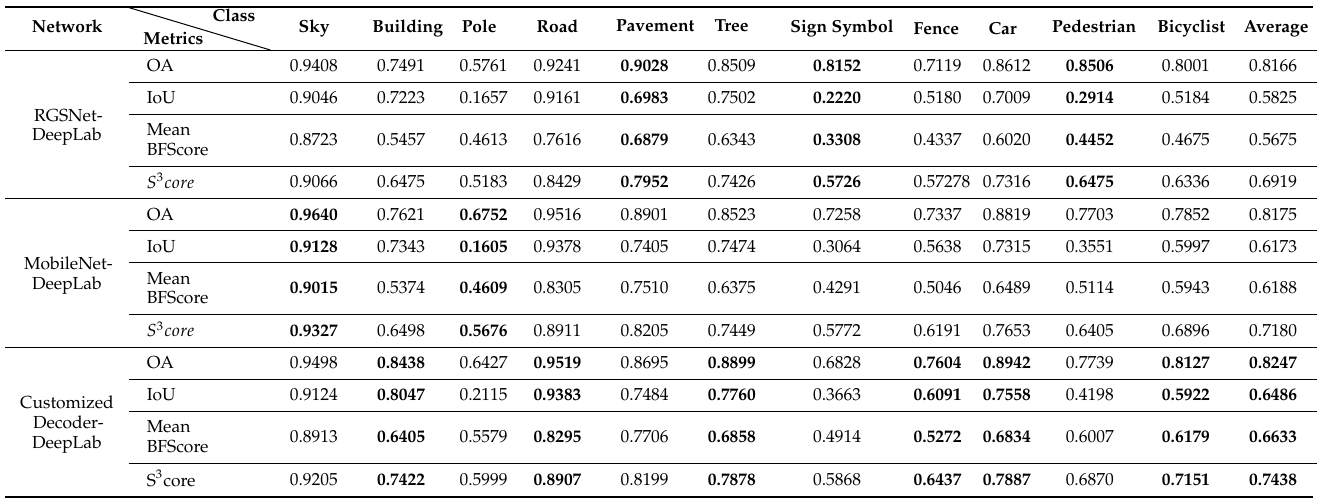
Table 6. Class-wise Accuracy